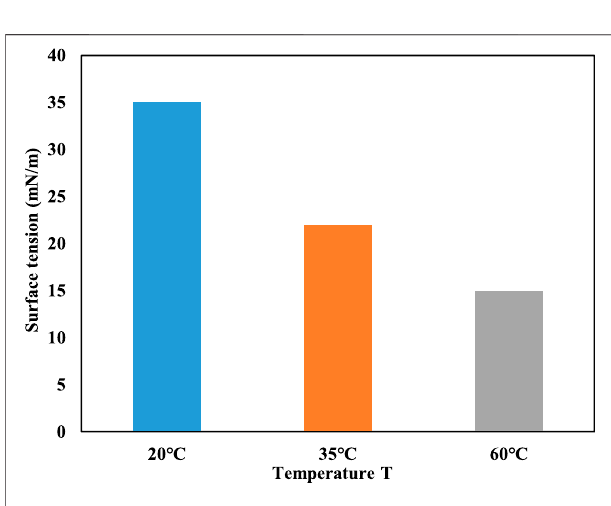
FIGURE 4 | IFT of crude oil – water system with different